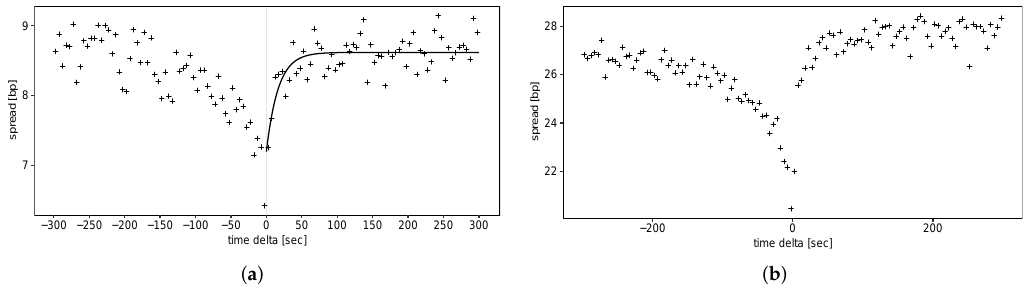
Figure A5. Resiliency of liquidity costs for the Bitstamp BTC/USD market. The figures display three different average measures of liquidity cost in the event time τ of the 1 percent largest trades. ( a ) Evolution of the average bid-ask spread ¯ s ( τ ) . We include the fit of an exponential function with exponential time constant T ≈ 16.6s to guide the eye; ( b ) Evolution of the average volume-weighted average price spread ¯ vs ( ω , τ ) for a volume of ω = 10 5 USD.